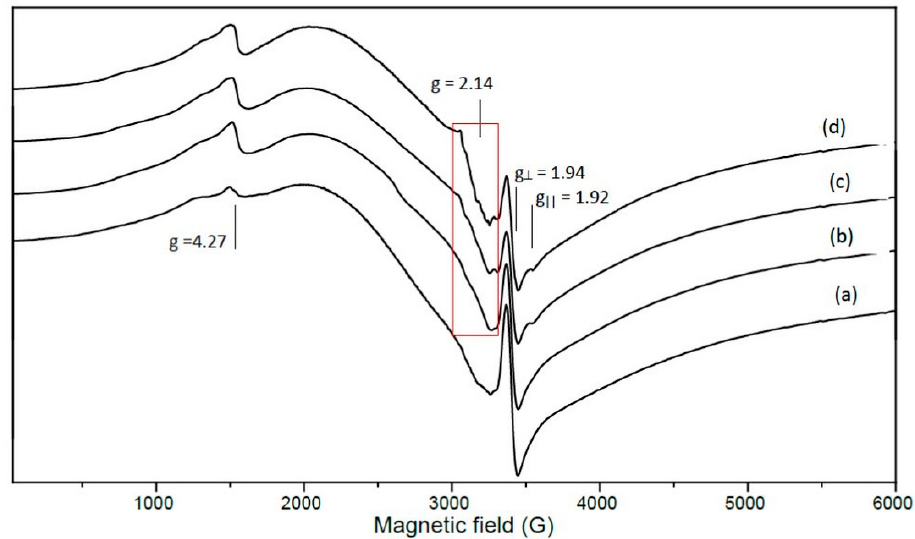
Figure 8. Electron paramagnetic resonance (EPR) spectra of monolith geopolymers before ( a ) and after the adsorption of mono-ionic Cu 2+ solutions with concentration ( b ) 4 mg/L; ( c ) 8 mg/L and ( d ) 12 mg/L. The signals of Cu 2+ are evidenced.